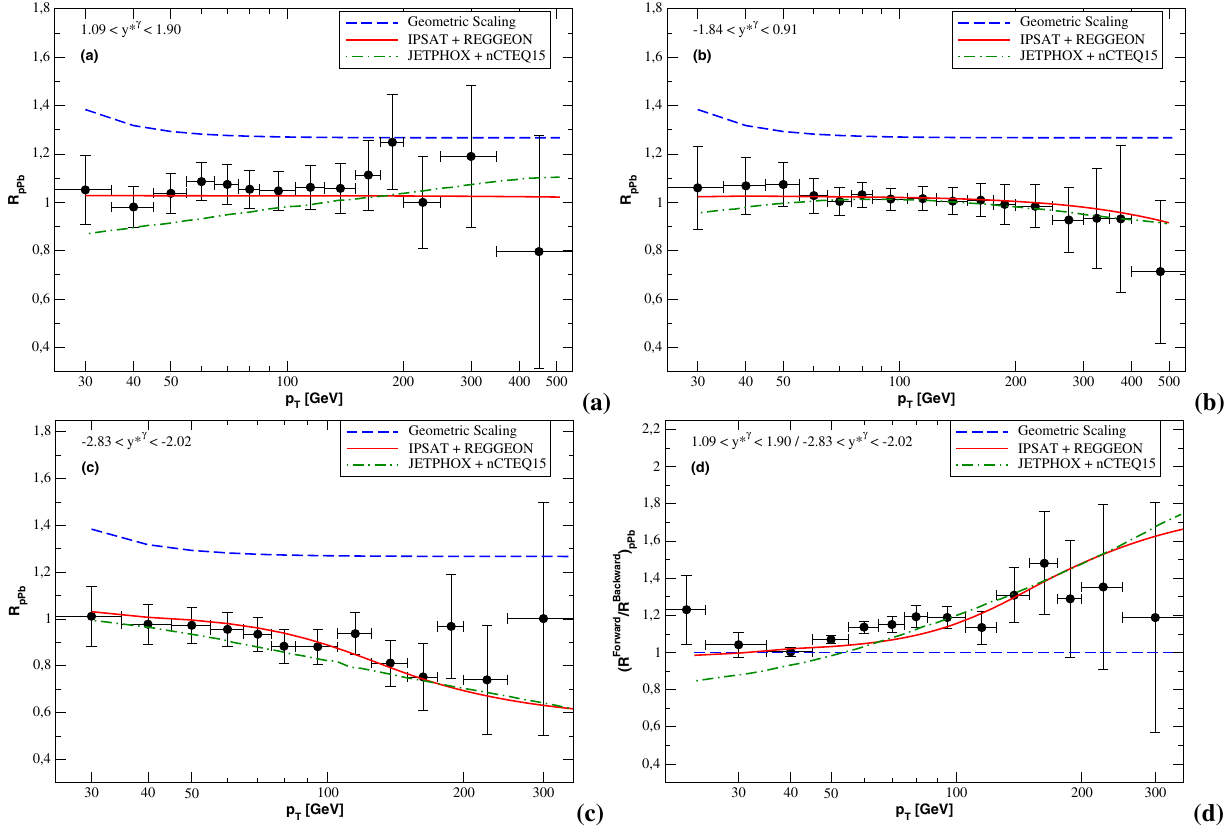
Fig. 6 Nuclearmodificationfactor R pPb forisolatedphotonsasafunc- using two phenomenological CD models (BUW and IPSAT) and com- pared to the NLO pQCD calculation including direct and fragmentation tion of photon transverse momentum, p T , shown for different center- √ s = 8 . 16 TeV. The predictions are obtained contributions to the cross section (with nuclear PDF of-mass rapidity, y γ ∗ at